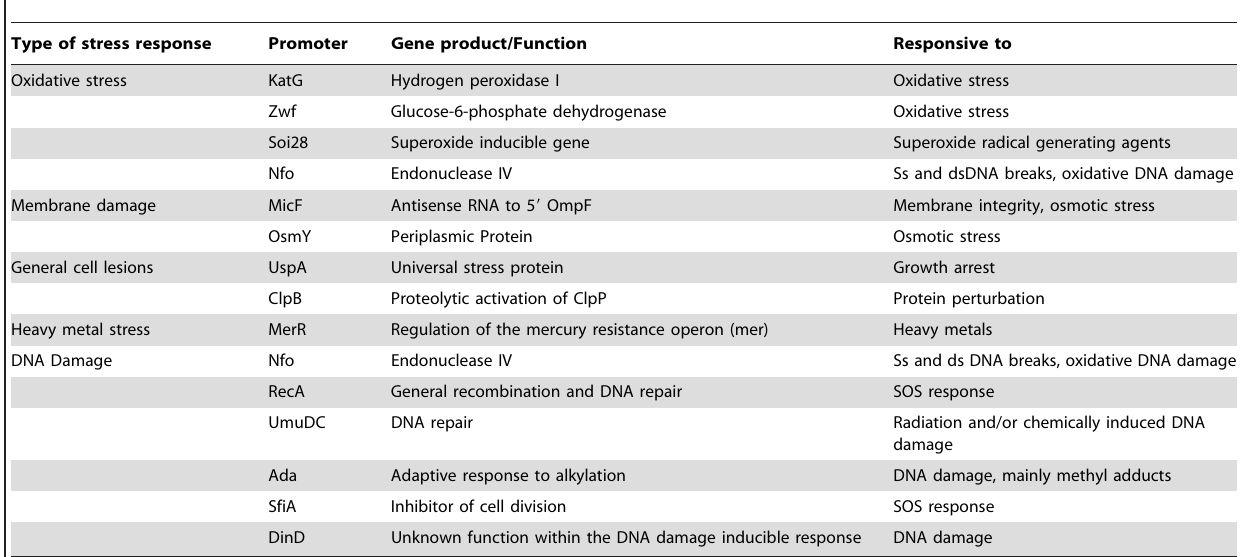
Table 1. Stress gene promoters fused to the LacZ gene and their functional grouping (modified from Dardenne et al., 2007 and Orser et al.,